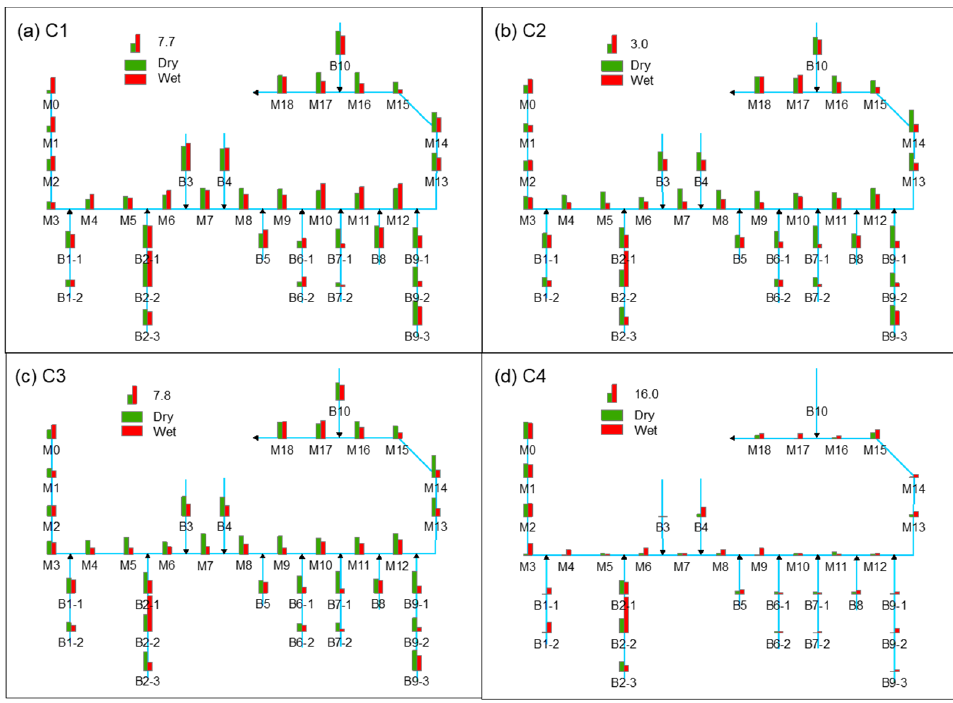
Figure 3. Spatial distributions of FDOM components of ( a ) C1, ( b ) C2, ( c ) C3, and ( d ) C4.